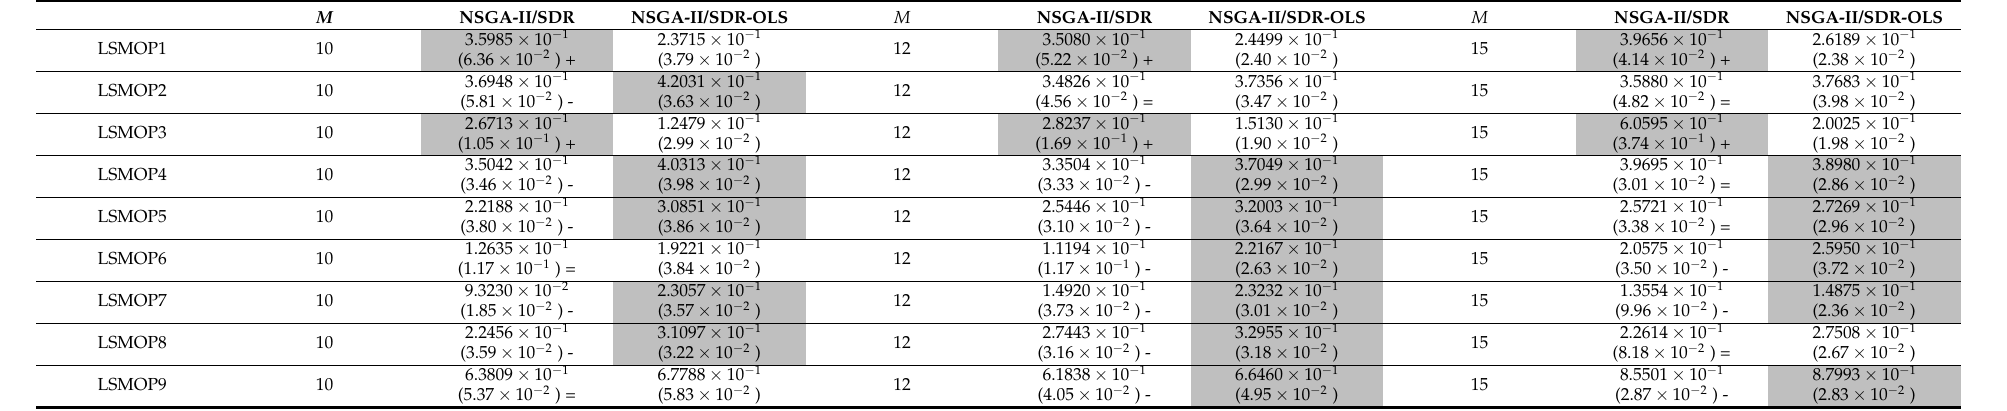
The gray background represents that this algorithm has the best performance on this problem. The number in the brackets represents the standard deviation of DM values, and the number out of the brackets represents the mean of DM values. “+/-/=” means that the relevant algorithm performs better than/worse than/as well as the NSGA-II/SDR-OLS algorithm in terms of DM